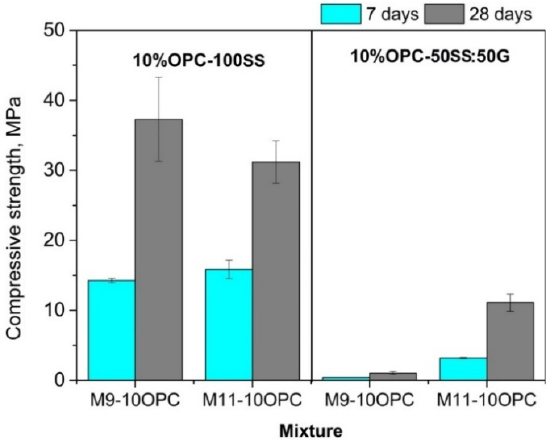
Figure 4. Compressive strength for hybrid pastes CW-OPC with different contents of SS.